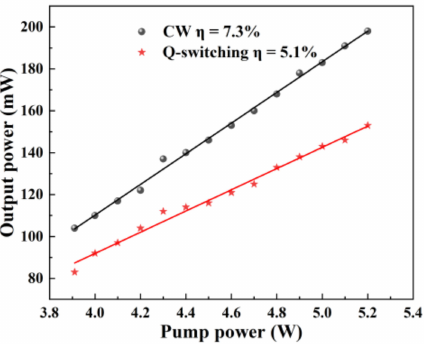
Figure 3. The average output power of the CW and pulsed Tm:YAP laser. A detector (Electro-Optics Technology, ET-5000, Traverse City, MI, USA) with 28 ps rise time and an oscilloscope (LeCroy, HDO4104A, New York, NY, USA) with 1 GHz bandwidth were employed to measure the pulse sequence of the pulsed Tm:YAP laser. The pulsed sequence well manifested the characteristics of pulsed laser. With an increase in pump power, the repetition rate frequency tended to be larger and the pulse duration tended to be narrower. When the power of the pump source was increased from 3.9 to 5.2 W, the repetition rate frequency increased from 43.44 to 70.08 kHz, while the pulse width reduced from 1.4 µ s to 821 ns, as shown in Figure 4a. The single pulse energy and peak power were calculated according to the output power, pulse width, and repetition rate. The dependence of peak power and single pulse energy on the incident power are shown in Figure 4b. The peak power and single pulse energy increased with the increase in pump power. When the pump power was higher than 5 W, the single pulse energy tended to be saturated, which was mainly due to the thermal effect on the SA. The single pulse energy was calculated to be 2.18 µ J, and peak power was 2.67 W under 153 mW average